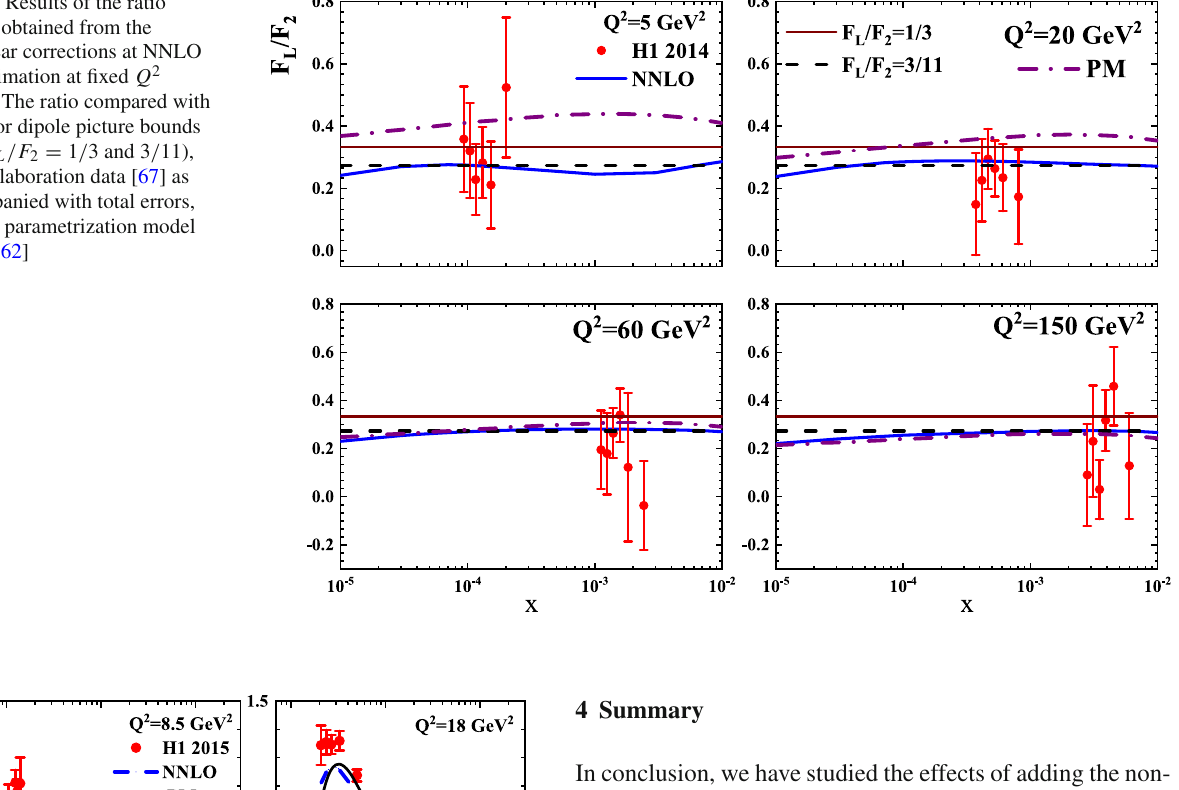
Fig. 6 Results of the ratio F L / F 2 obtained from the nonlinear corrections at NNLO approximation at fixed Q 2 values. The ratio compared with the color dipole picture bounds (i.e., F L / F 2 = 1 / 3 and 3 / 11), H1 Collaboration data [67] as accompanied with total errors, and the parametrization model [11,61,62]